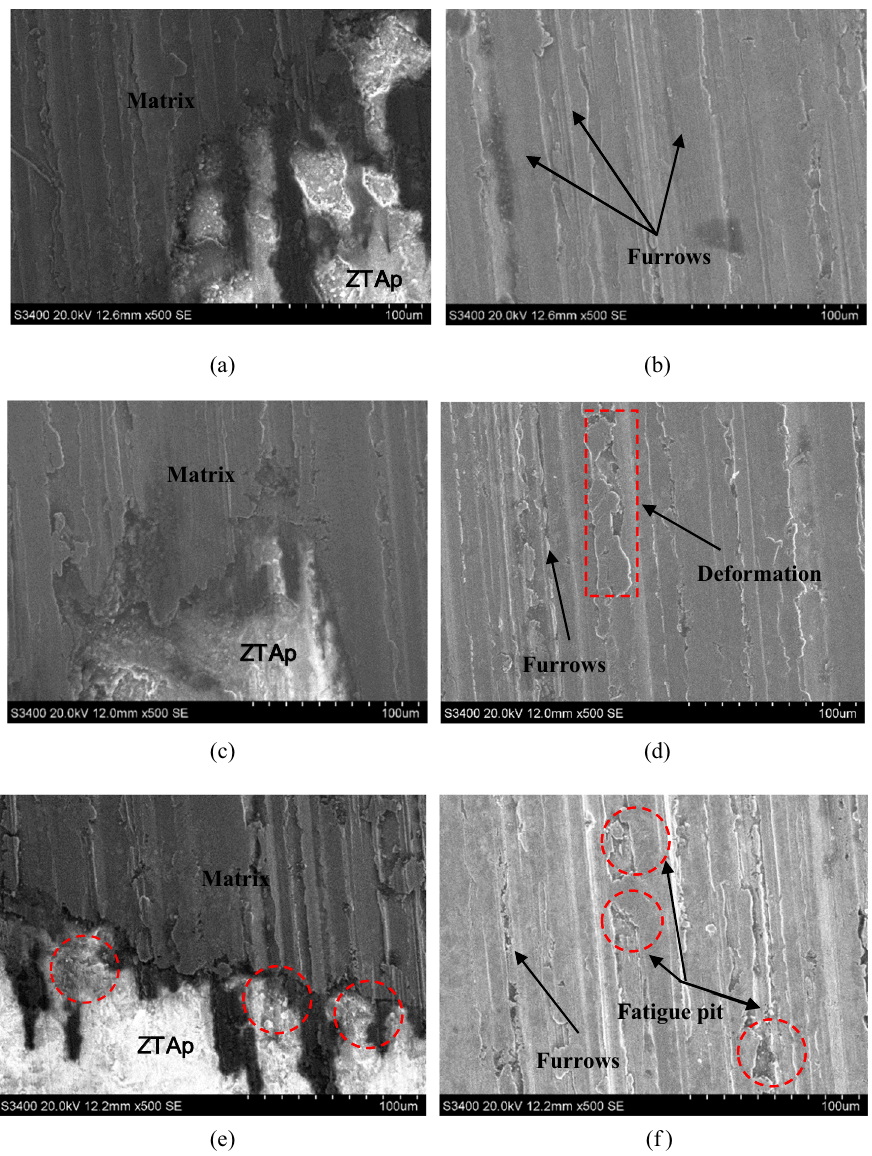
Figure 7: E ff ect of rotation speed on material wear morphology: ( a and b ) 100 N, 100 rpm, ( c and d ) 300 N, 300 rpm, and ( e and f ) 400 N, 400 rpm.